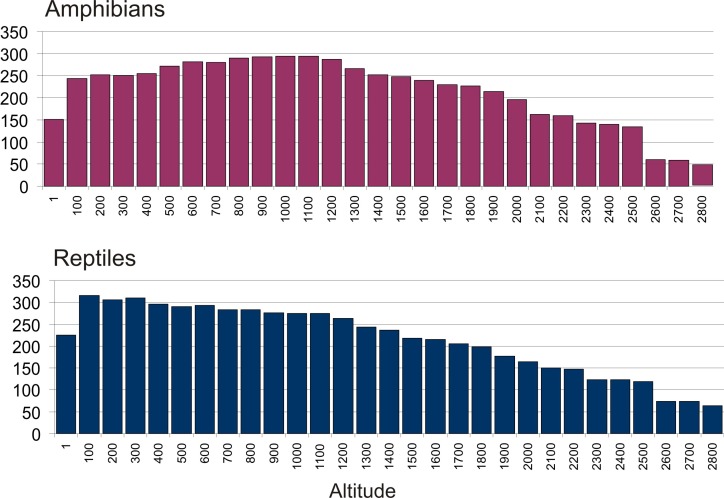
Species richness by elevation.Number of specimens of amphibians and reptiles, predicted by the adjusted SDMs to occur at certain elevations at intervals of 100 m above sea level. Presumably due to over-prediction the inferred elevational ranges probably are larger than the realized ones, giving higher numbers of species than actually occurring in lowlands and high elevations.